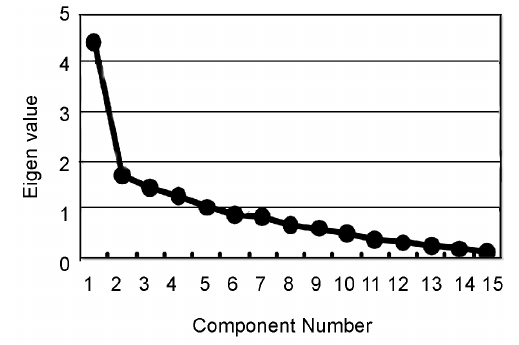
Fig. 4. The Scree Plot for All of the 15 Driving Factors Table 8 is the rotated component matrix, in which to make the output easier to read absolute values less than 0.5 are suppressed. Each row of Table 8 contains compo- nent loadings, the correlations between each variable, and the component (the dimension of the driving factors). The component loadings indicate which factor group belongs to which component. The first component has the largest variance and therefore can explain the problem most ef- fectively. The second component is independent of the first component and contains as much of the remaining information in all best-value risk management objectives as possible, and so on.